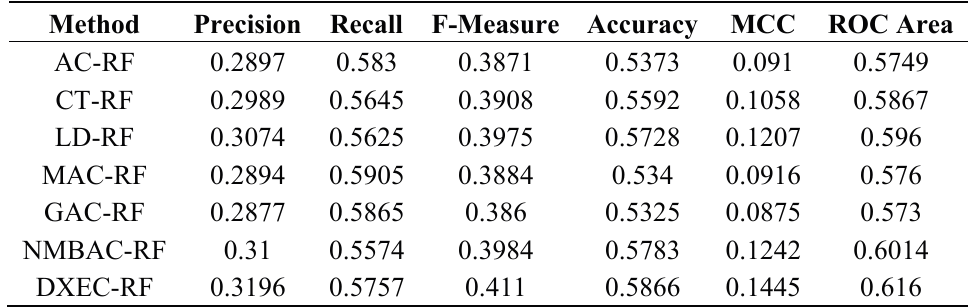
Table 1. Performance comparison of seven methods on the Yeast All dataset by using the Gold Yeast model. AC, autocovariance; RF, Random Forest; CT, conjoint triad; LD, local descriptors; MAC, Moran autocorrelation; GAC, Geary autocorrelation; NMBAC, normalized Moreau–Broto autocorrelation; DXEC-RF, the DX feature selection method and ensemble coding (EC) encoding.